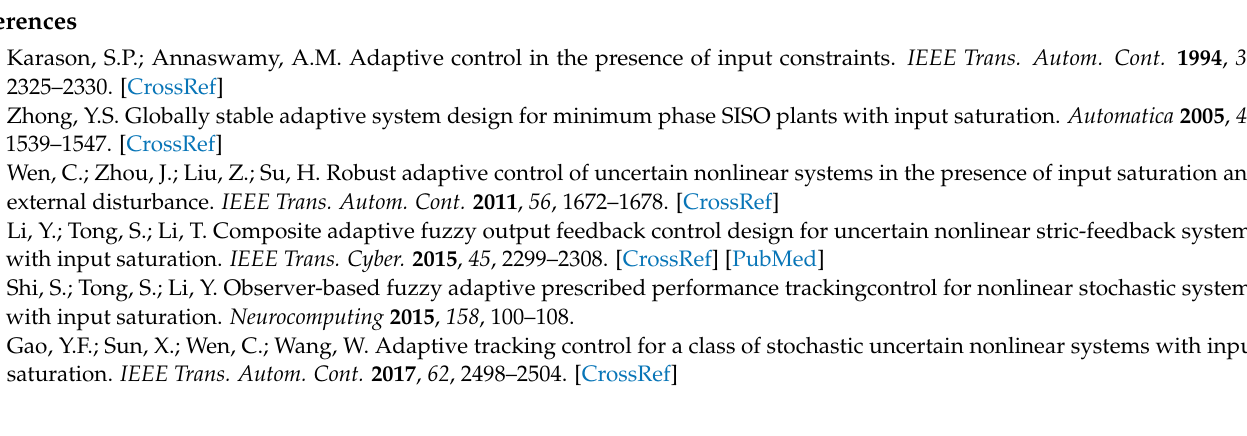
Figure 9. RBFNNs outputs and adaptive parameters for experiment ( a ) ˆ W